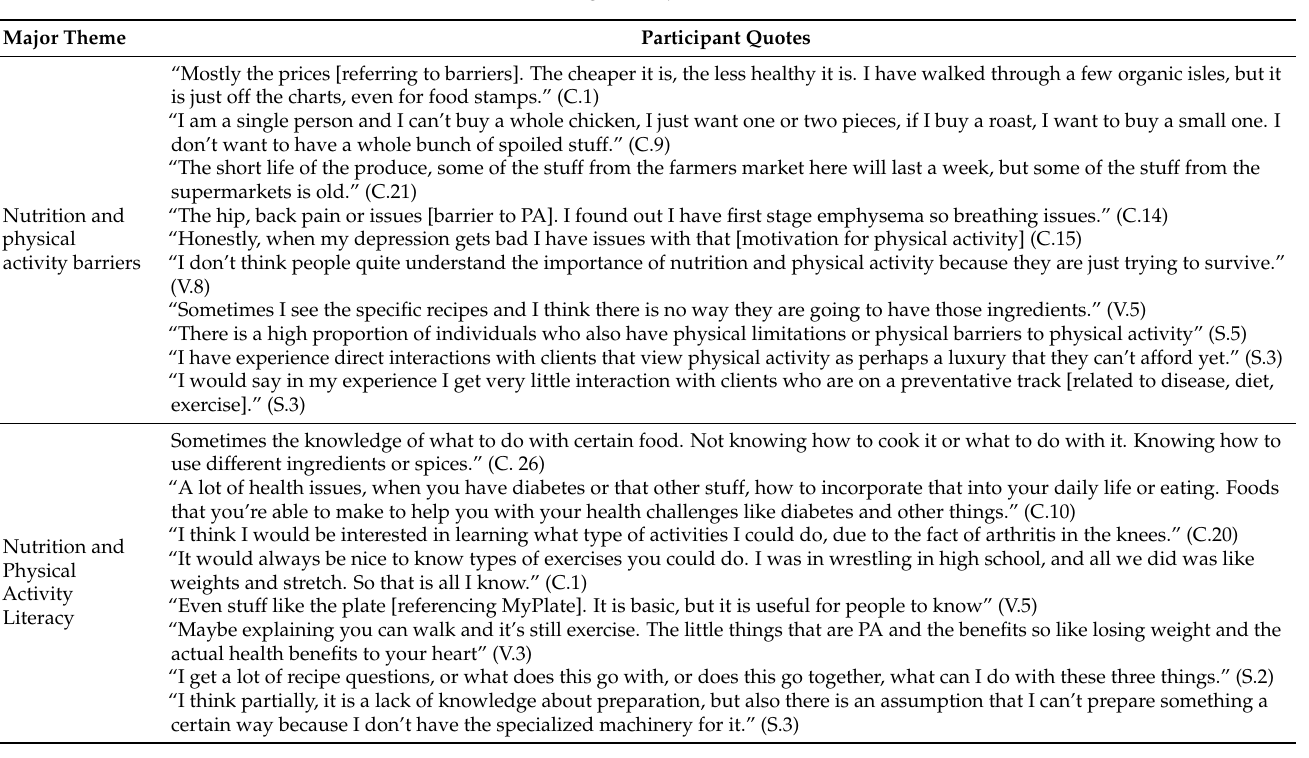
Table 2. Final convergent Major Themes and